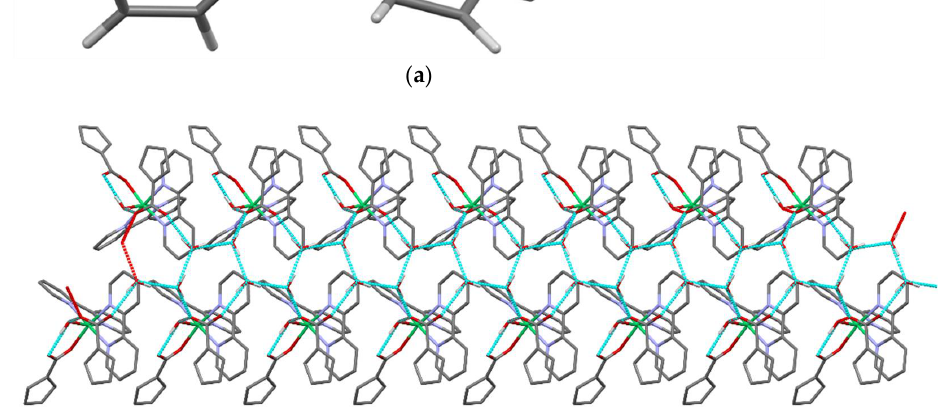
Figure 4. The molecular structural unit of compound 6 ( a ) and double 1D-chains in its crystal structure ( b ). The distances between the coordinating atoms of the ligands and the Ni 2+ ion are given (Å).